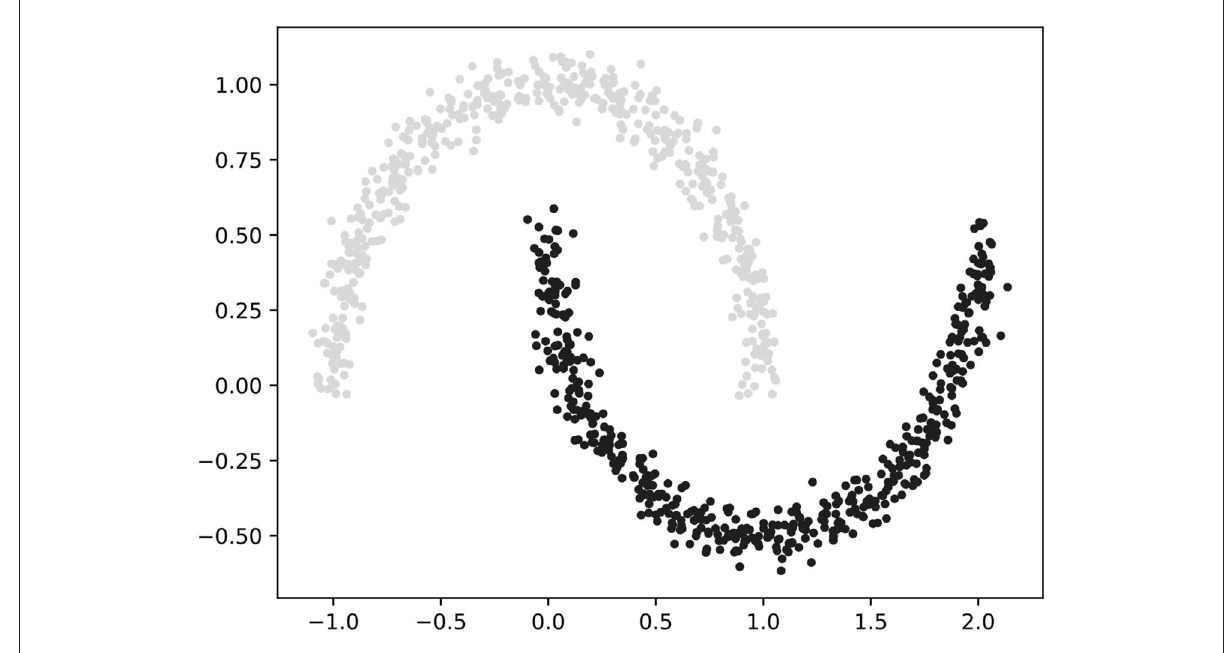
FIGURE2 Clustering results of